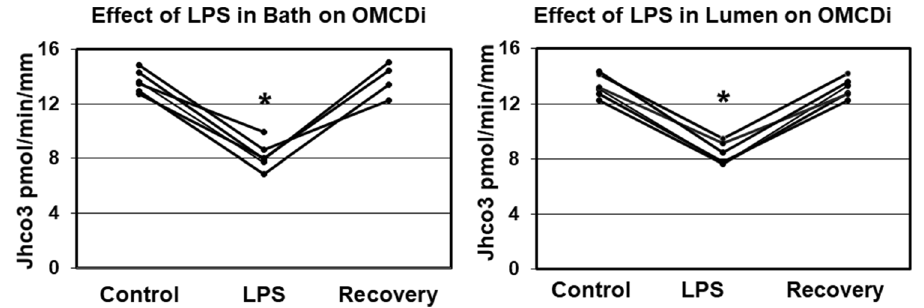
Figure 1. LPS added to the bath (L panel) or to the lumen (R panel) at 500 ng/ml inhibits HCO 3 absorption by ~ 40% in OMCDs from the inner stripe (n = 6 for each